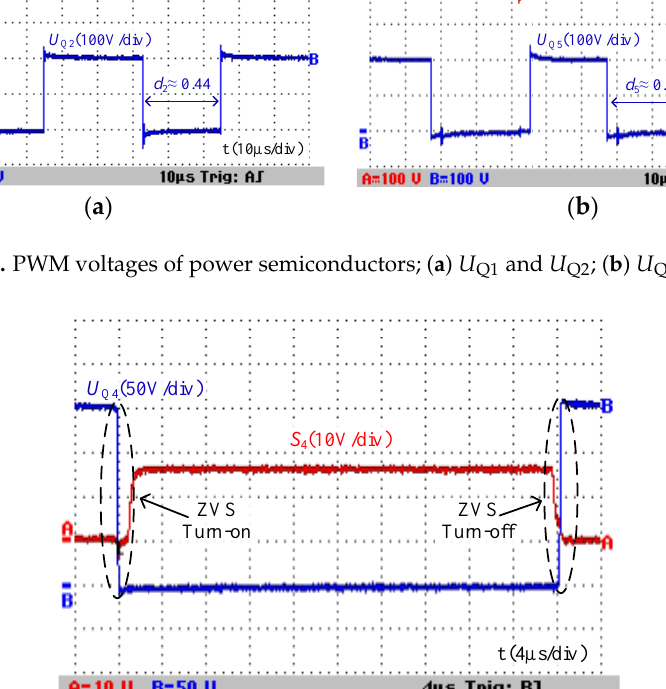
1 and inductor current i L .